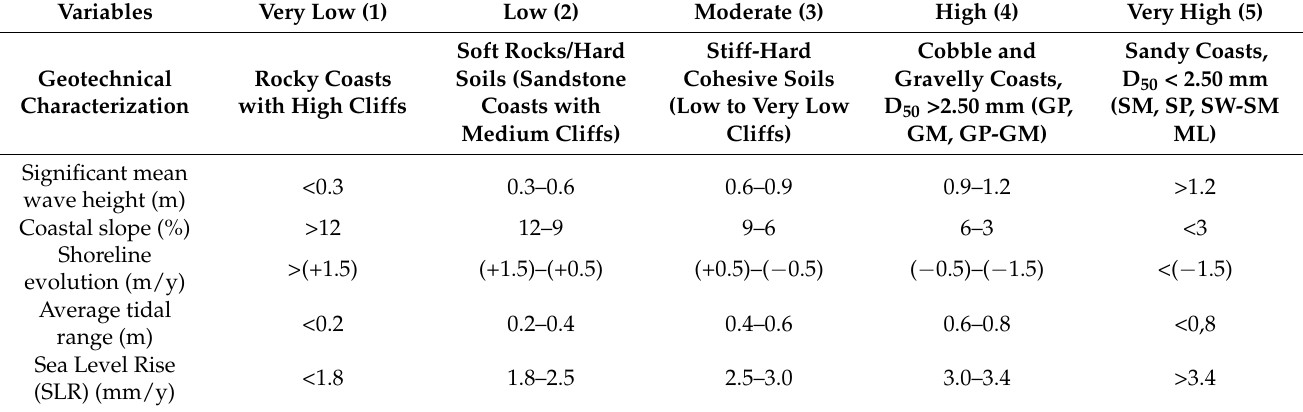
Table 3. Ranges of vulnerability ranking for each of the variables used in the Coastal Vulnerability Index (CVI) calculations.